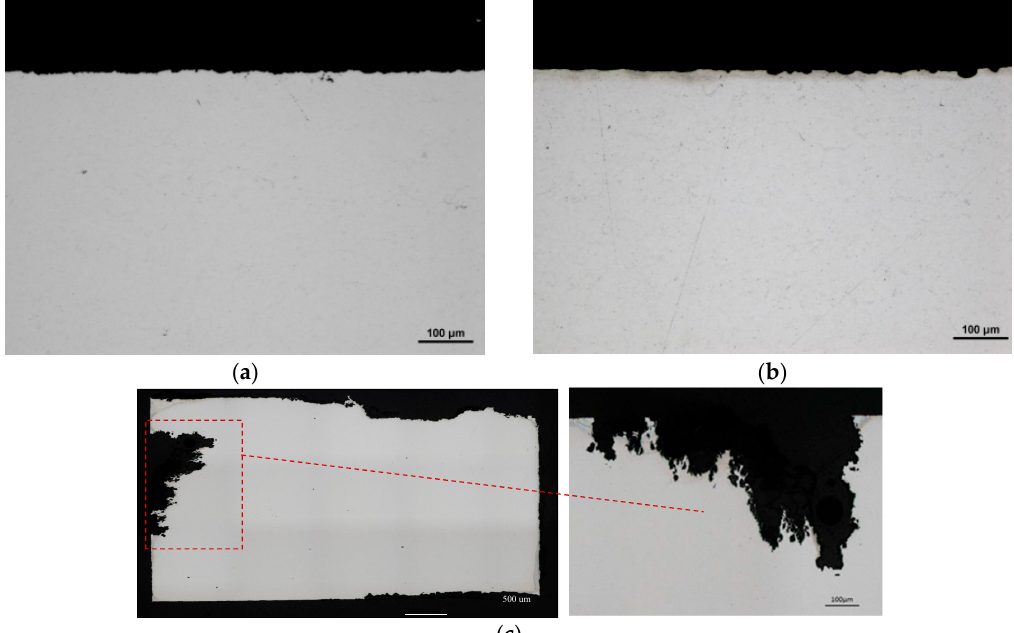
Figure 15. Metallographic sections of cold spray samples at ( a ) 25% yield strength and ( b ) 65% yield strength after 90 days exposure to B117 salt fog testing. There is no indication of stress corrosion cracking through branching or evidence of any other artifacts related to corrosive attack on failed sample cross sections; ( c ) Metallographic sections of cold spray samples at 85% yield strength after 90 days exposure to B117 salt fog testing. There is no indication of stress corrosion cracking through branching on the entire cross section. Evidence of slight corrosive attack is observed and identified on the figure.